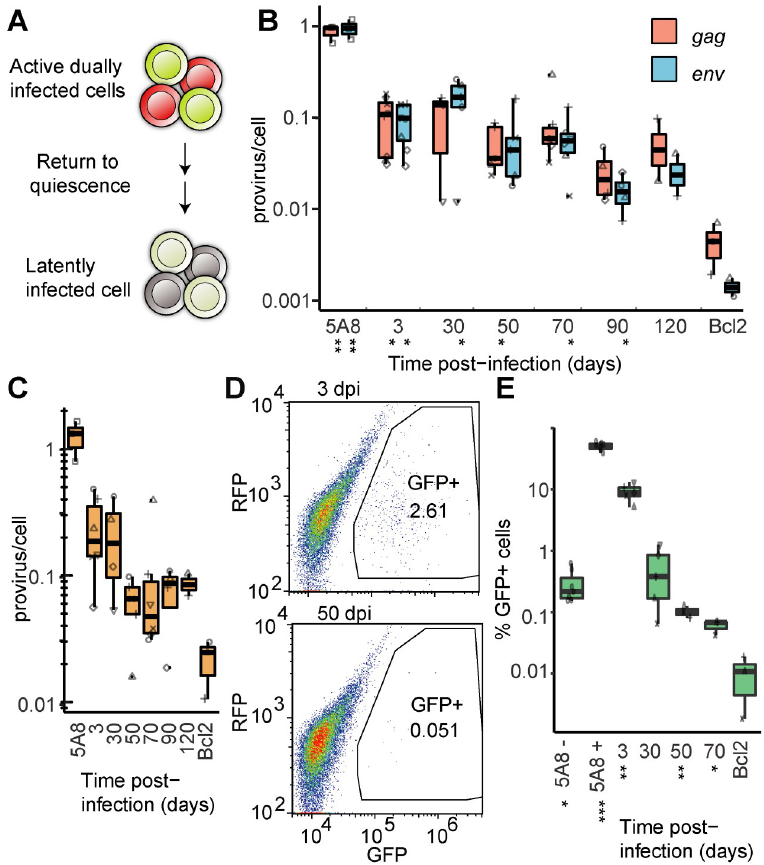
Fig 3. Diminishing activation potential of the HIV-1 provirus in resting T-cells in time. ( A ) Active cells were transferred to cytokine-free media to return to quiescence. ( B ) Proviruses quantified by ddPCR at the gag and env loci. Signals normalized to endogenous rrp30 . J-lat clone 5A8 has a single integrated provirus and the Bcl2-only cells have been infected with the Bcl2-virus but not the HIV-reporter virus. ( C ) Proviruses quantified by ddPCR at the 5´ LTR locus. Signals normalized to endogenous rrp30 . ( D ) Flow analysis of cells at 3 and 50 dpi gated for GFP-positive cells expressing the GFP-containing HIV-reporter provirus. ( E ) Quantification of GFP positive cells in time, with addition of 5A8 treated with DMSO (5A8-) or PMA/i (5A8+) for 24 hours. � p < 0.05, �� p < 0.01 (below the x-axis), calculated by unpaired t-test in panels (B) and (E), comparing each probe and time-point to the Bcl2 control.